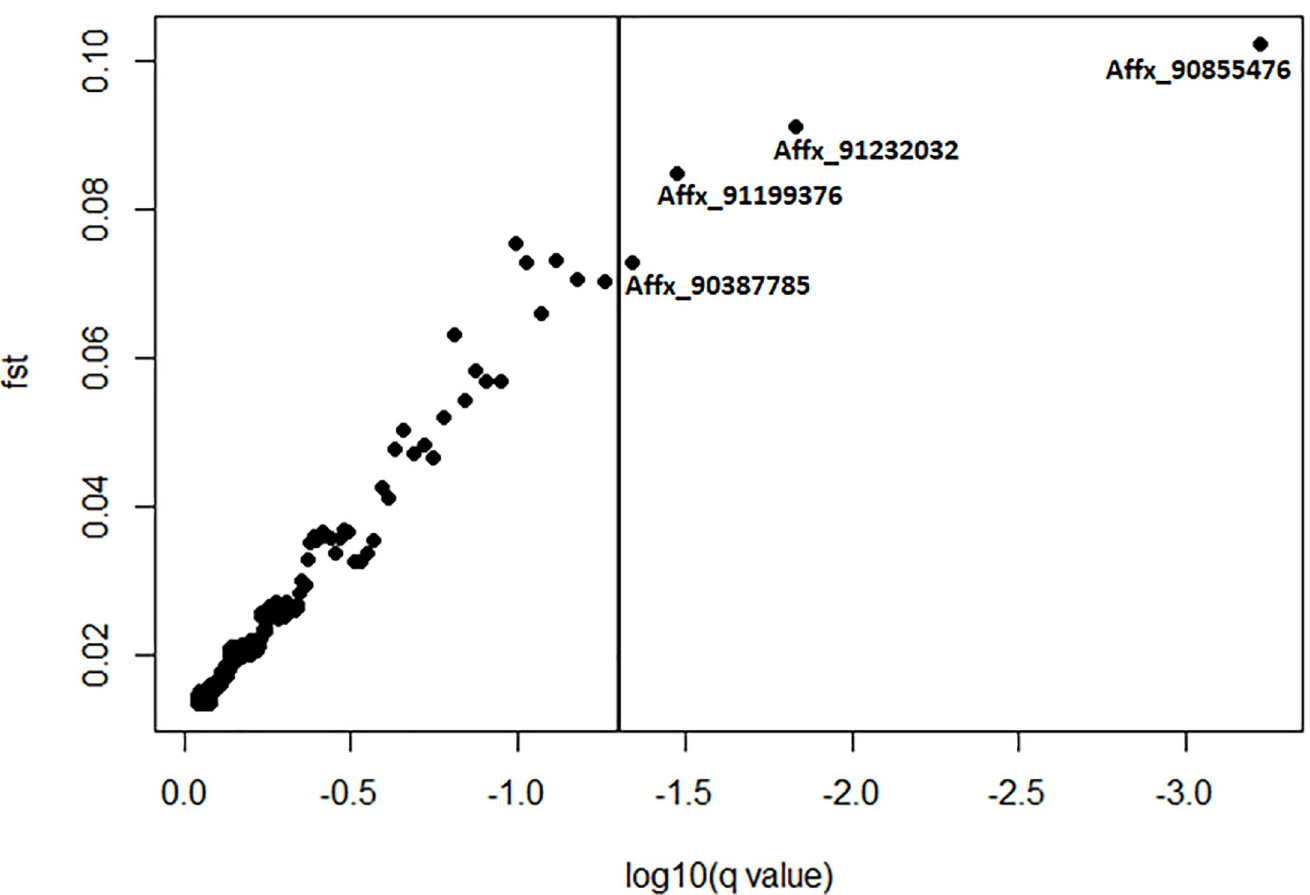
Fig 5. Plot representing the BAYESCAN results. The vertical line represents a false discovery rate (FDR) threshold of 0.05. Points to the right of the vertical line represent SNPs under directional selection between H_LNAE and L_LNAE groups.